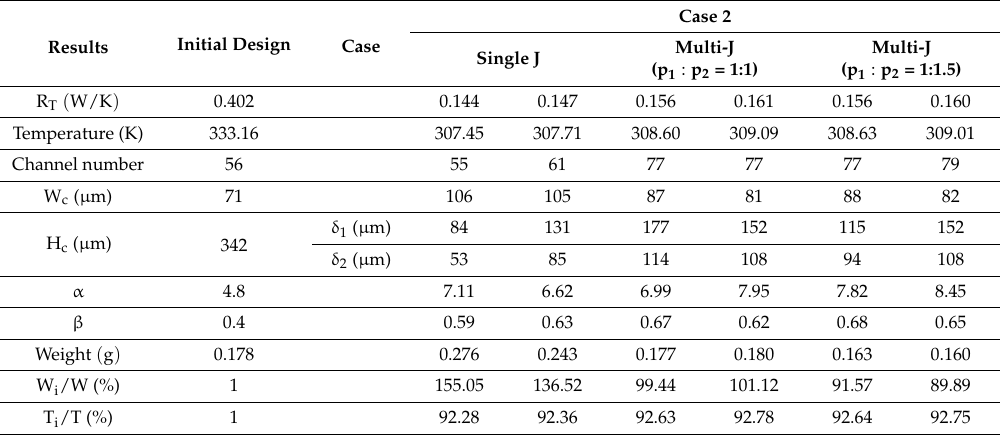
Table 6. Optimal results of the single and multi-objective function in Case